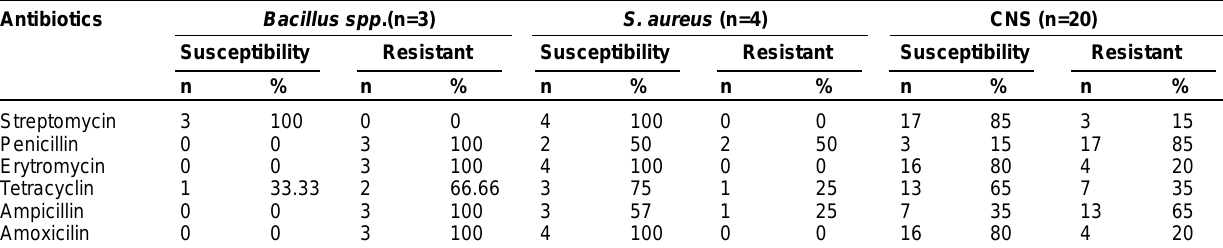
Table-1(b): Antibiotic susceptibility of bacterial isolates ( from subclinical mastitis goats Bacillus spp , S. aureus and